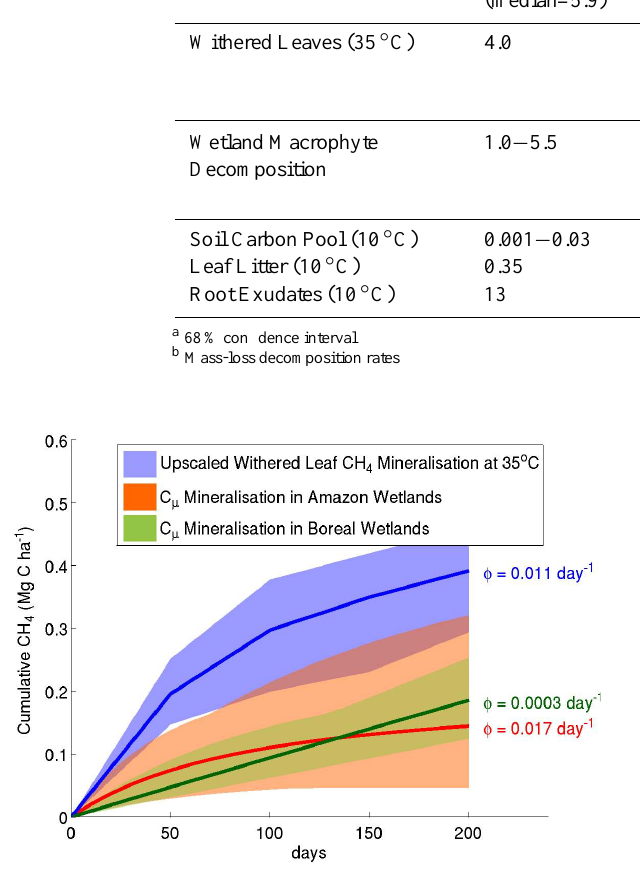
Fig. 2. Cumulative CH4 emissions over a 200-day period from model C µ mineralisation and incubated withered leaves. Blue: me- dian and range of values from Miyajima et al. (1997). Red (green): median and 68% confidence interval range of CH 4 emissions from the Amazon River basin (boreal wetland) from C µ and φ values when N µ = 0. A total litter stock of 17.5MgCha − 1 (Malhi et al., 2009) was used to upscale the Miyajima et al. (1997) CH 4 mineral- isation rates.